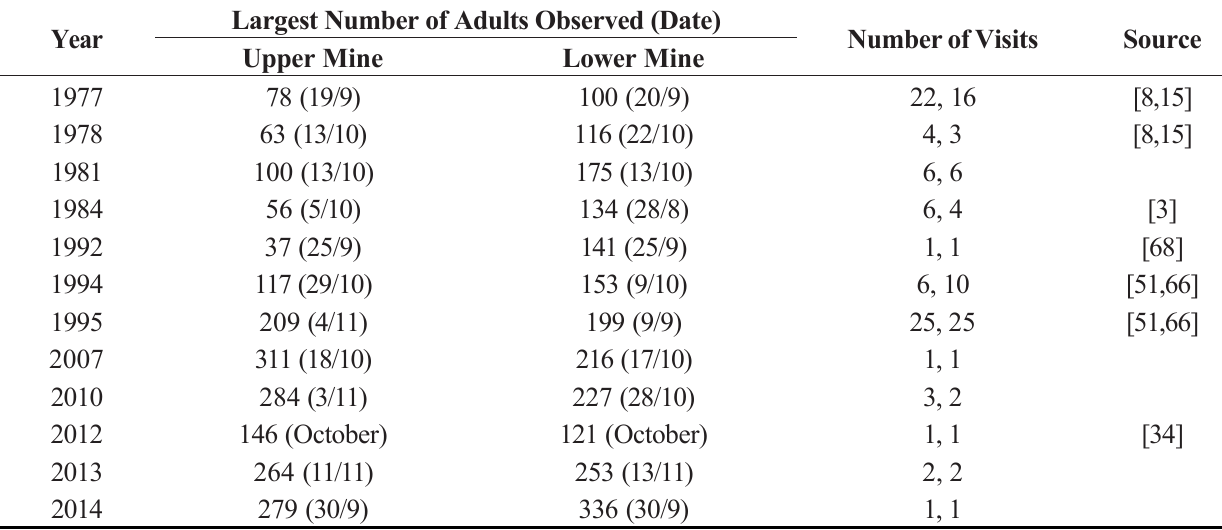
Table A3. Poço do Inferno mine